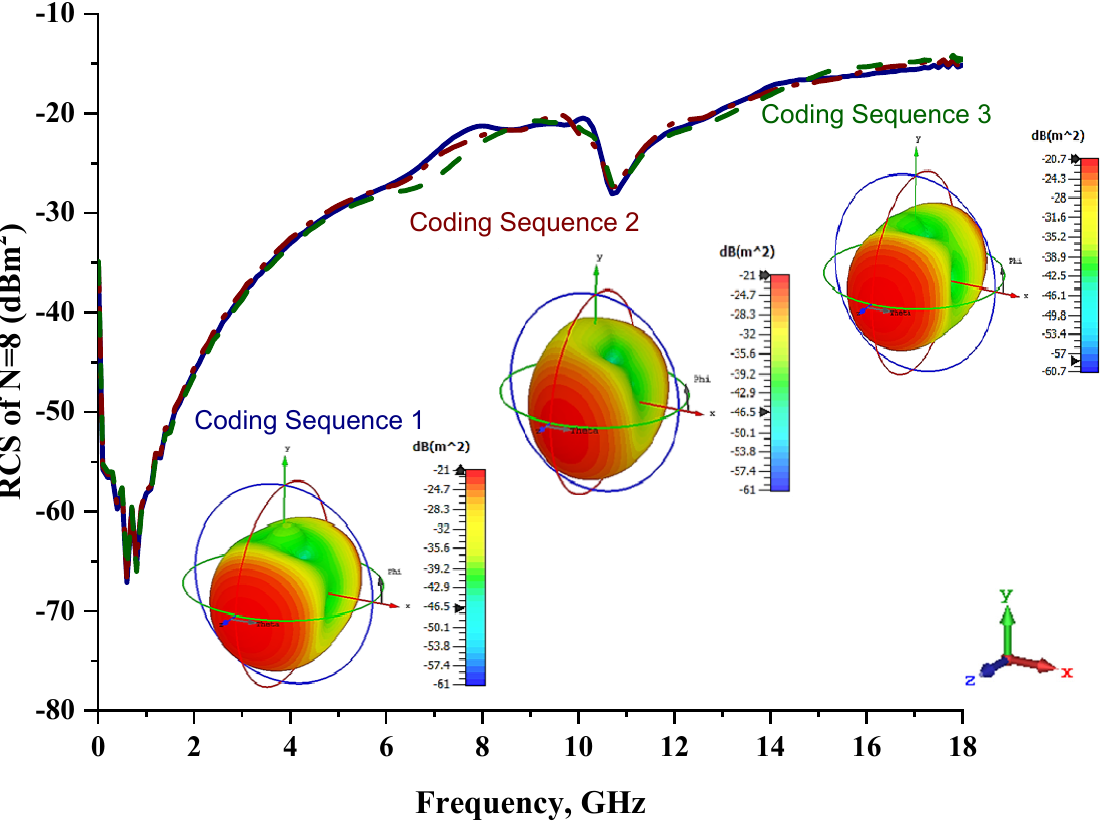
Figure 8. Monostatic RCS and bistatic scattering patterns (at 8 GHz) of three different coding metamaterials with eight lattices. Table 8. Coding sequences of n = 8 for each row.